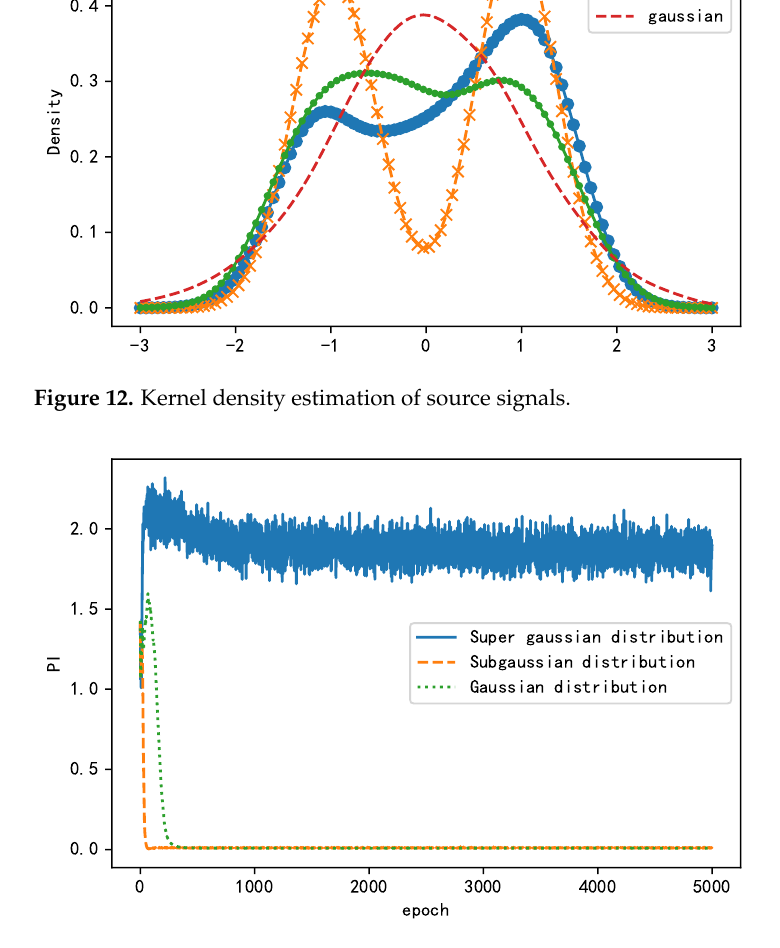
Figure 13. Performance index of corresponding algorithm with different